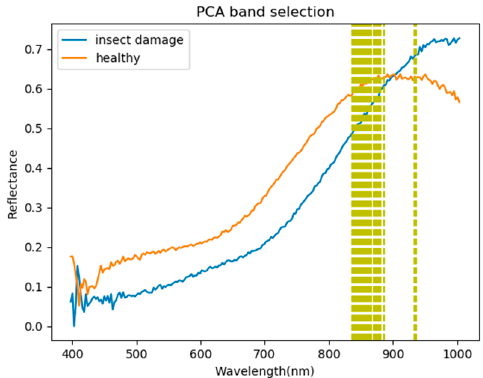
Figure 15. Visualization of the PCA band selection results. The first five bands are 936, 875, 872, 869, and 866 nm.